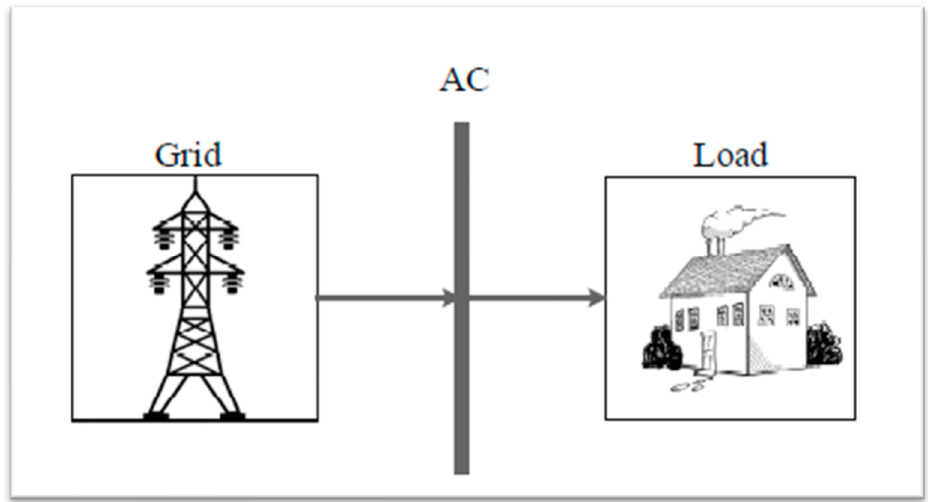
Figure 7. Grid-connected load without a backup power system.